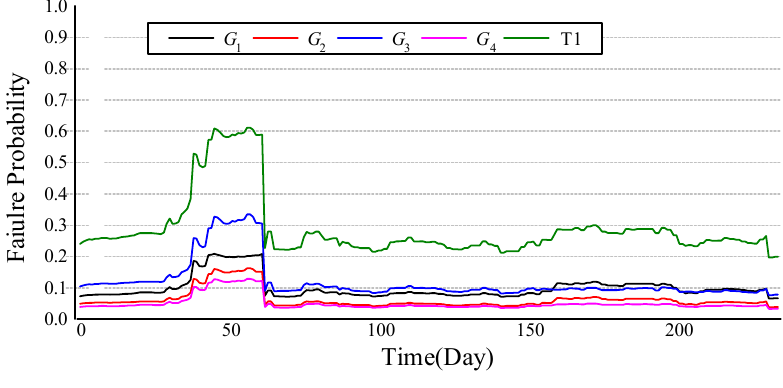
Figure 9. The failure probability calculation result of T1. Table 5. The content of the dissolved gas in T2 (uL/L).